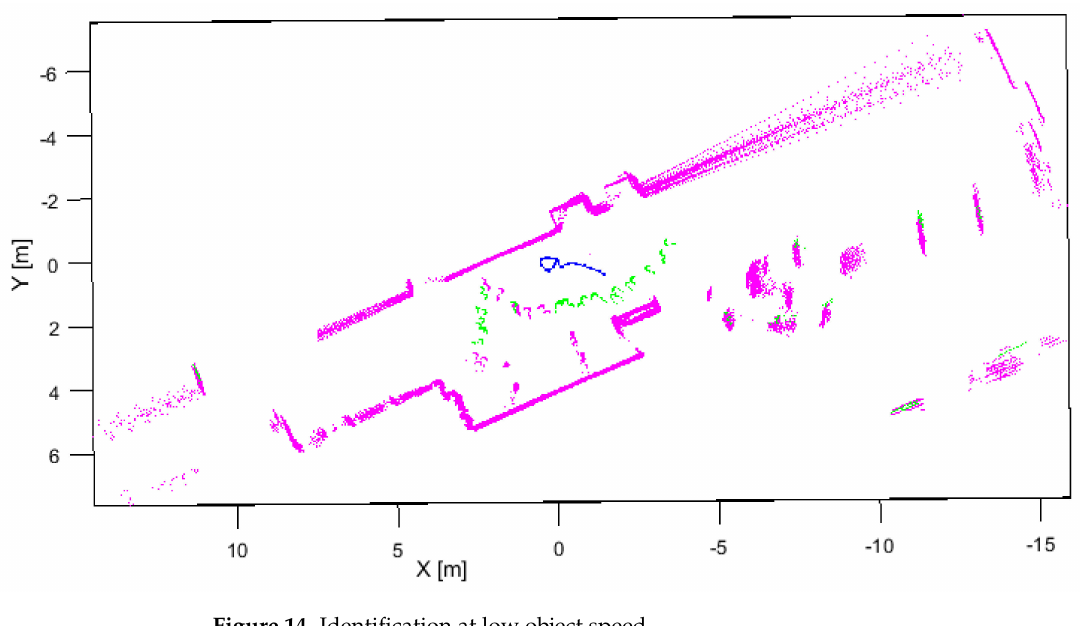
Figure 14. Identification at low object speed.